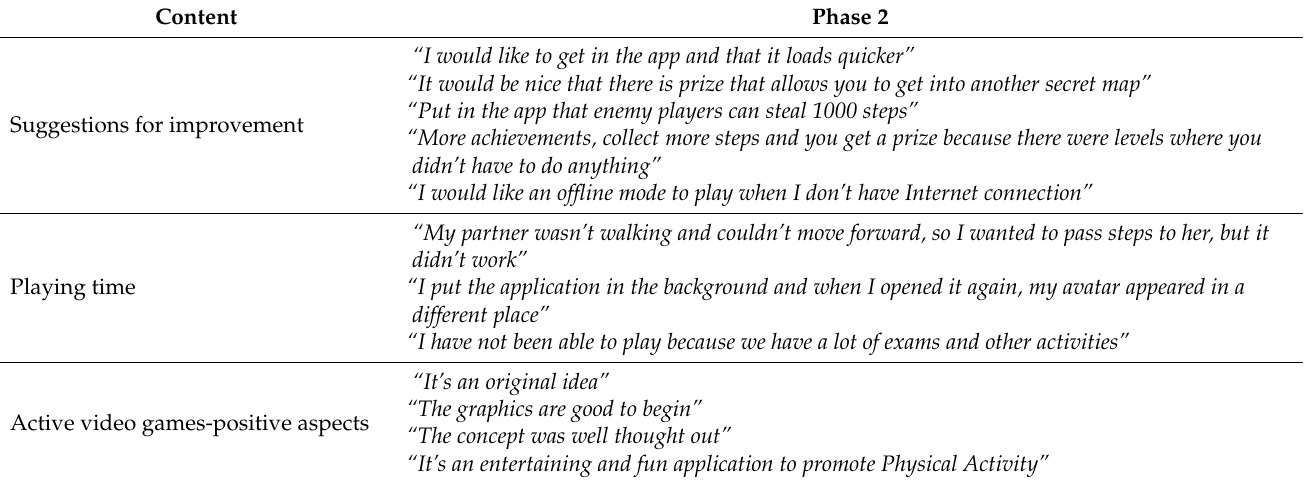
Table 4. Adolescents’ perceptions about the app Mystic School in phase